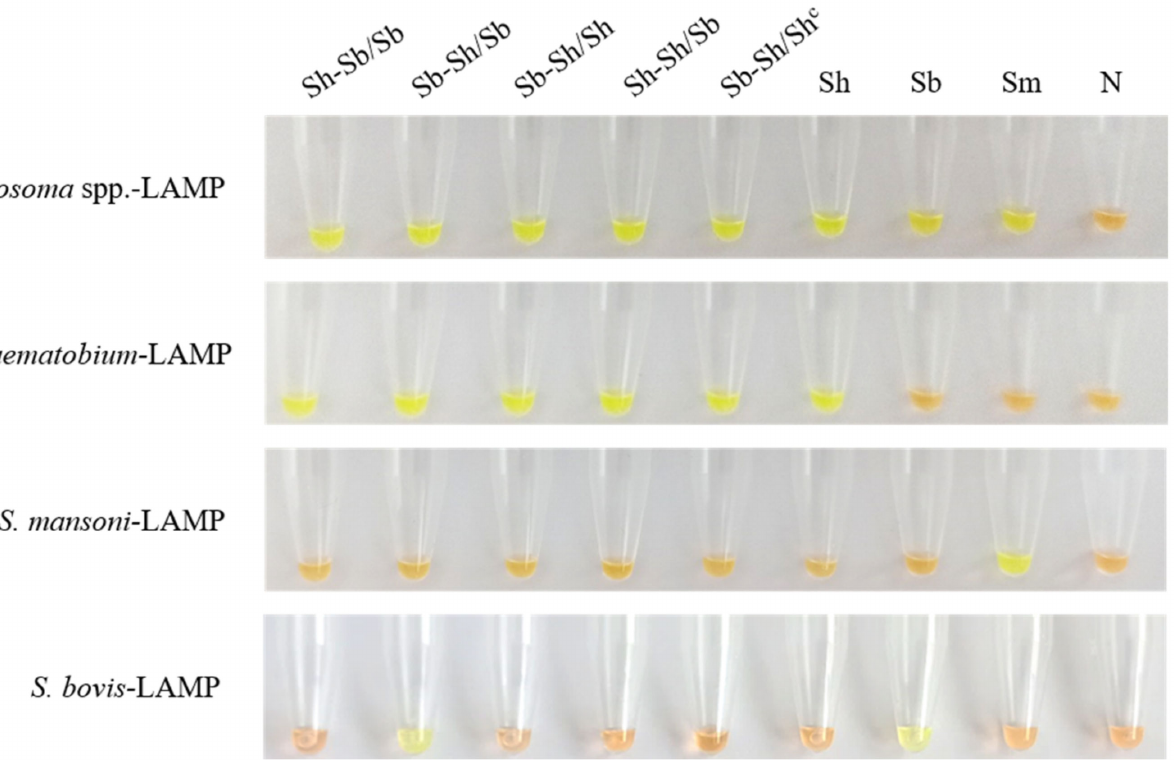
Figure 1. Schisto -LAMP assays performance in testing DNA samples from both pure Schistosoma species and hybrids. Schistosoma spp.-LAMP, the genus-specific LAMP for detecting several schistosome species; S. haematobium -LAMP, S. mansoni -LAMP and S. bovis -LAMP, the species-specific LAMP assays for detecting S. haematobium , S. mansoni and S. bovis , respectively. Sh-Sb/Sb, Sb-Sh/Sb, Sb-Sh/Sh, Sh-Sh/Sb, DNA from schistosomes hybrids from Agboville. Sb-Sh/Shc, corsican hybrid schistosome. Sh, Sb, Sm, DNA from pure S. haematobium , S. bovis and S. mansoni , respectively. N, negative control (no DNA